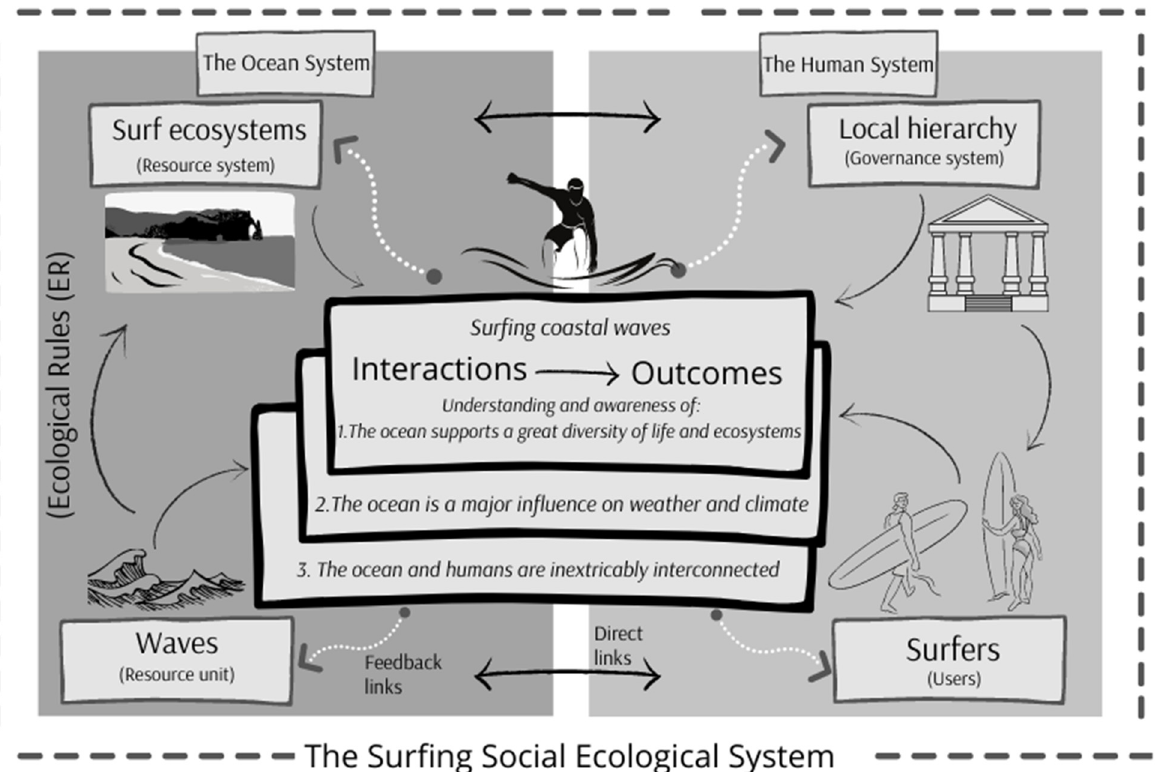
Figure 1. The Surfing Social Ecological System model is adapted from McGinnis and Ostrom [59] and demonstrates how the human (social) and ocean (ecological) systems provide opportunities for interactions between surfers (users) and waves (resource units), producing ocean literacy understanding and awareness.